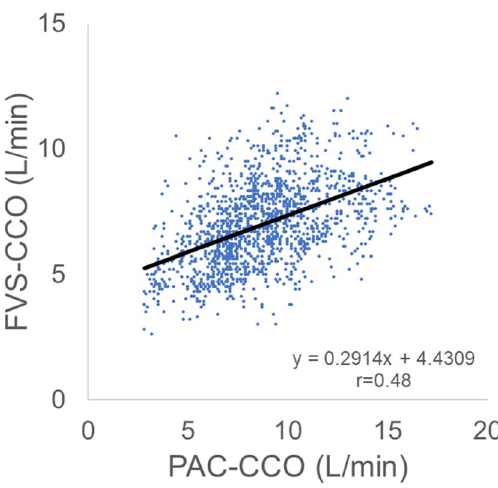
Figure 2. Linear regression and Pearson correlation analysis for all data pairs. The Pearson correlation coefficient (r) for PAC-CCO vs. FVS-CCO was 0.48, indicating a moderate